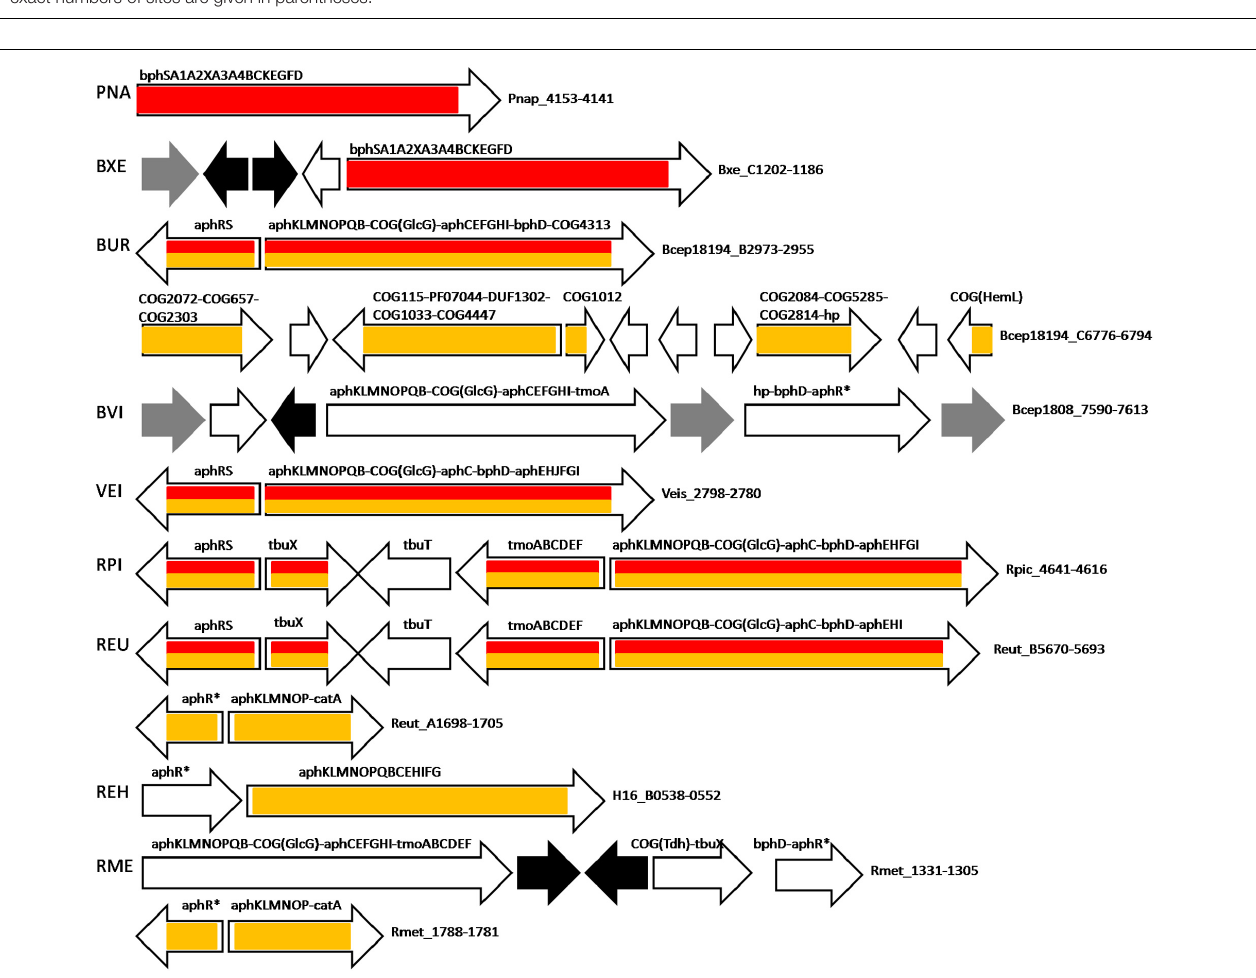
FIGURE 3 | Operon organization and regulation of aromatic metabolism genes regulated by AphS/BphS and AphR in Burkholderia spp., P. naphthalenivorans CJ2, Ralstonia spp., and V. eiseniae EF01-2. Color denotes regulation by the following TFs: AphS/BphS – red, AphR – orange. Double coloring denotes dual regulation. Genes/operons are shown by arrows, black arrows denote pseudogenes, gray – transposases; “hp” indicates hypothetical proteins. Genome abbreviations as in Supplementary Table S2 .